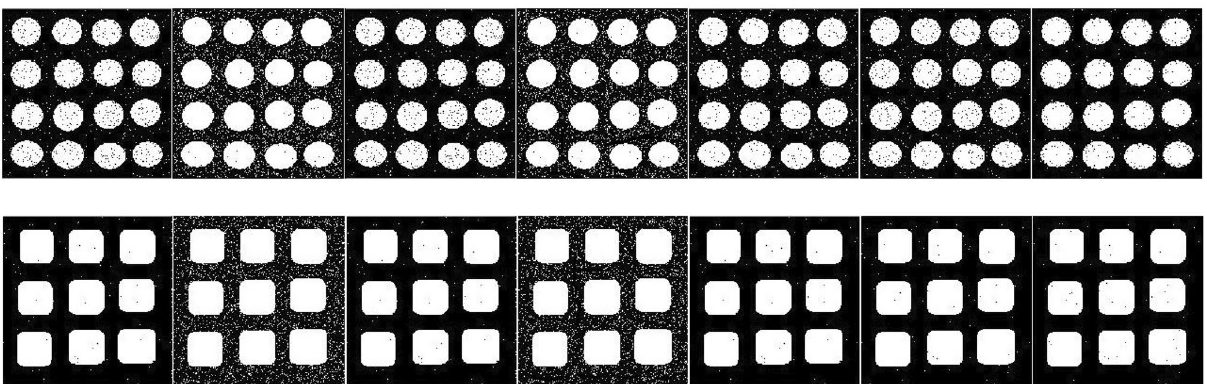
Figure 3. Thresholding segmentation results of the noised synthetic image by using different methods. For each experimental synthetic image, the results of OTSU, KSW, CHPSO_otsu, CHPSO_ksw, GLLV, GABOR and WPWLPT methods are displayed side by side from left to right.